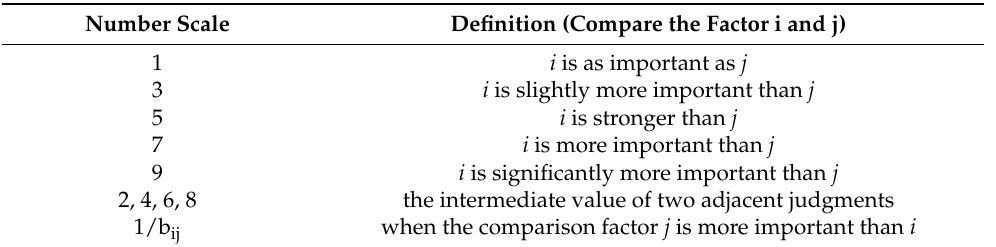
Table 1. Scale of preference between two